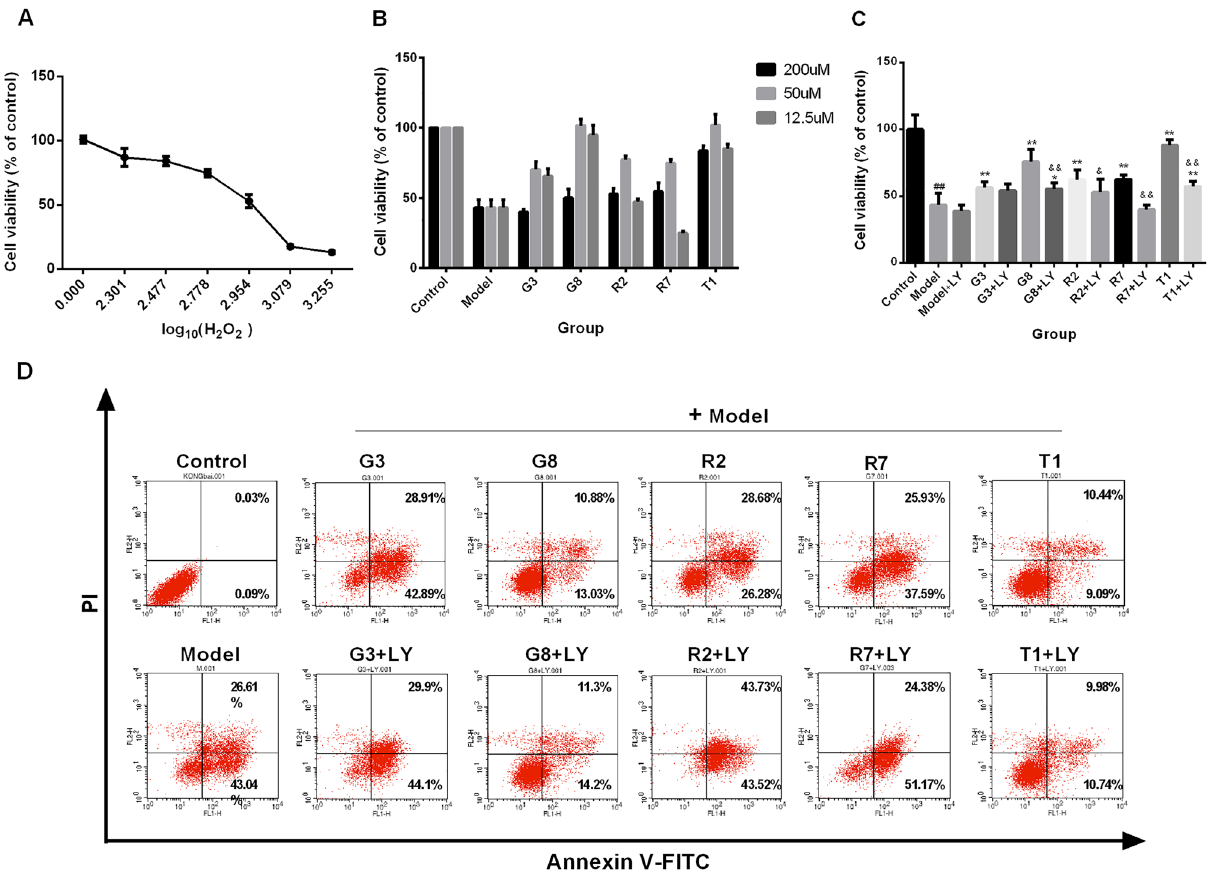
Figure 4. Effects of the activemonomers of SWTX on H 2 O 2 -induced H9c2 cell oxidative injury. ( A ) H9c2 cells treated with 200–1800 μΜ H 2 O 2 for 22 h, shown marked reductions with increasing dose in cell viability ( n = 6). ( B ) 12.5, 50, 200 μΜ G3, G8, R3, R5 and T1 pretreated H9c2 cell for 2 h and co-incubated with 900 μΜ H 2 O 2 for additional 22 h, significantly improved H9c2 cell viability in comparison to the cells singly treated with 900 μΜ H 2 O 2 , among them, G8 and T1 shown best ( n = 6). ( C ) The protective ability of 50μΜ G8, R3, R5 and T1 groups is significantly reduced by PI3K inhibitor LY294002 (50 nM) in H9c2 cell ( n = 6). ( D ) The cell apoptosis ratio was detected by flow cytometry, and the data indicated a decreasing percentage of cells in the lower and upper right quadrants (early and late stage apoptosis) in 50 μM G3, G8, R2, R7 and T1 groups compared with 900 μΜ H 2 O 2 group, and an increasing percentage of the apoptosis cells following LY294002 (50 nM) treatment . ## P < 0.01 versus control group; ** P < 0.01 versus model; * P < 0.05 versus model; && P < 0.01 monomer versus LY294002 + monomer and & P < 0.05 monomer versus LY294002 +